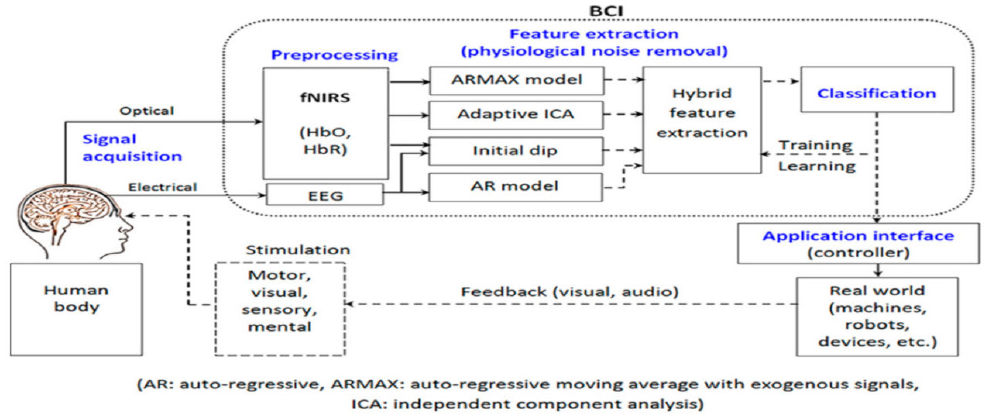
Figure 5. An example of a combined fNIRS and EEG brain–computer interface system. (Reprinted from